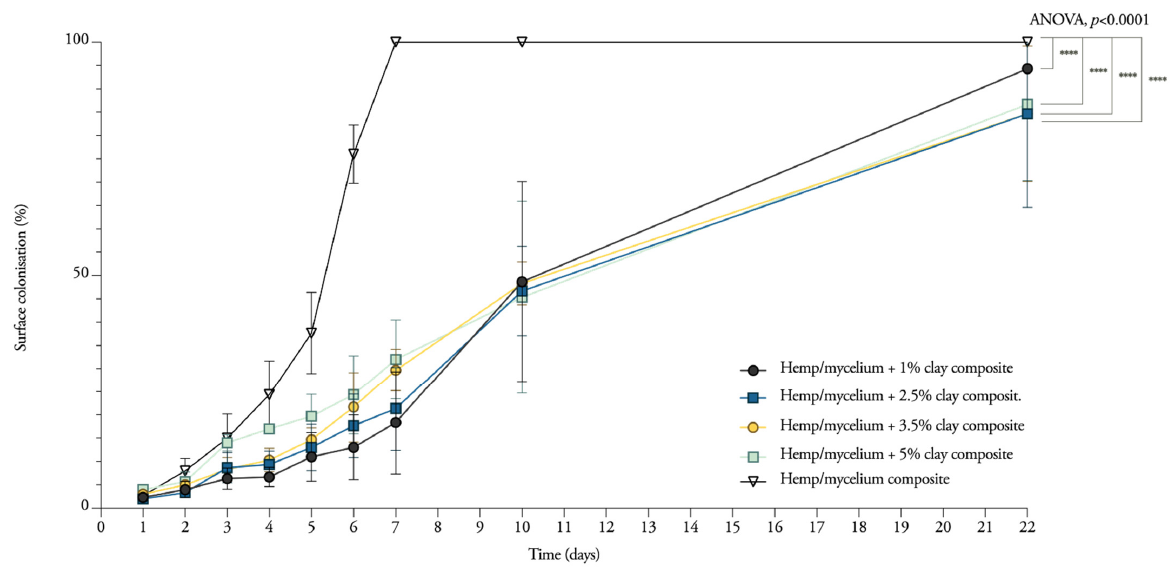
Figure 3. Radial mycelium extension rate measured as surface colonized (%) over 22 days for T.